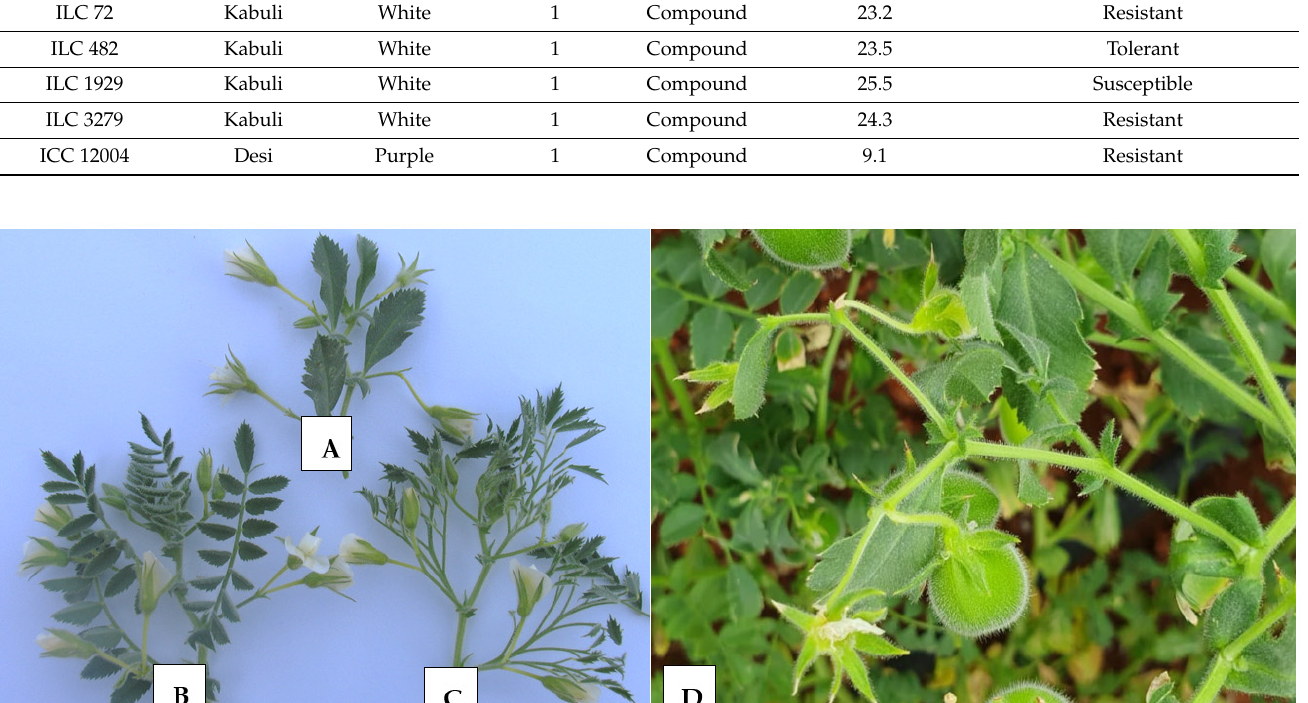
Figure 1. Leaf types and number of flowers per peduncle in cultivated chickpeas. ( A ) Simple-leafed and single-podded (Sierra), ( B ) compound-leafed and double-podded (CA 2969), ( C ) multipinnate- leafed and double-podded (Mutant), and ( D ) simple-leafed and multi-podded.